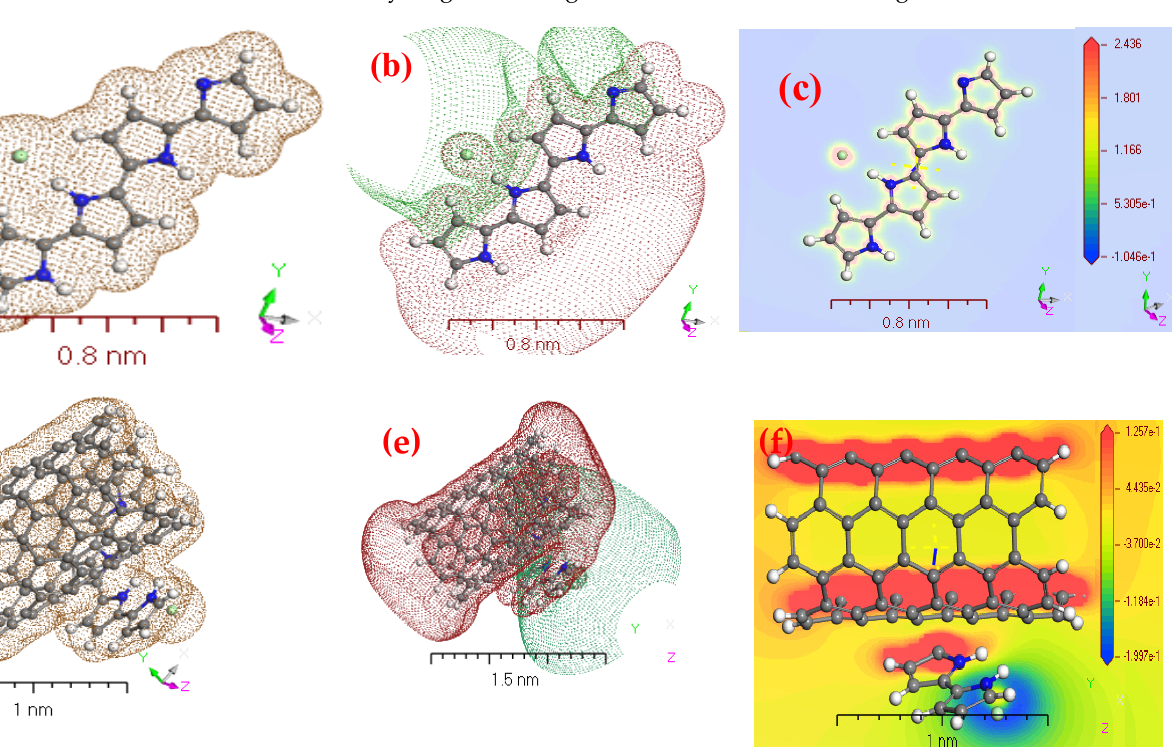
Figure 3. The geometry parameters in isolated state for ( a ) electron density of PPy; ( b ) potential of PPy; ( c ) electrostatic potential (MEP) of PPy; ( d ) electron density of PPy/MWCNTs composites; ( e ) potential of PPy/MWCNTs composites and ( f ) MEP of PPy/MWCNTs composites using DMOl 3 /DFT programs. The measured ∆𝐸 (cid:3034)(cid:3016)(cid:3043)(cid:3047) values were based on the highest occupied molecular orbital